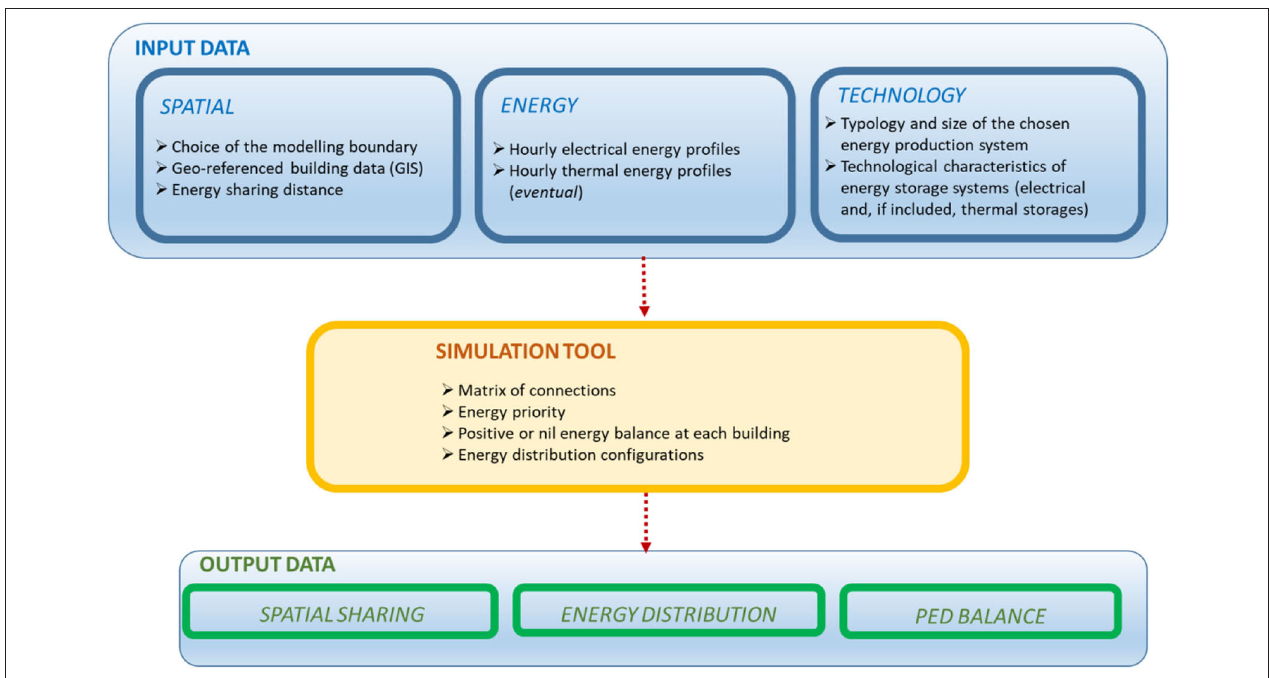
FIGURE 1 | Overview of the proposed